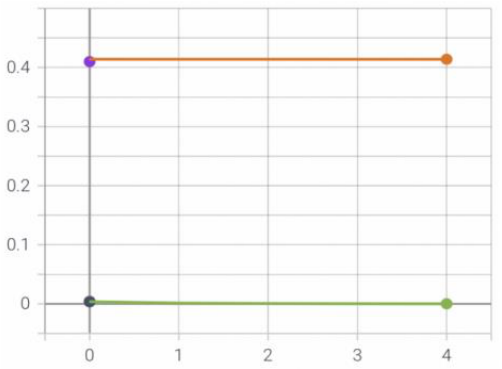
Figure 3. 1–train loss vs. validation loss (orange line represents the validation loss while the green line is the training